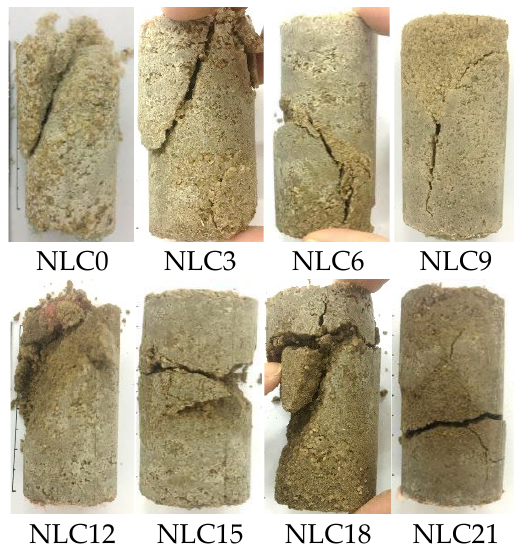
Figure 6. Destruction pattern with different clay contents (MICP-Treat). Figure 6 indicates that when the clay content is 0%, the sand particles are peeled off after the sample is damaged and become loose after damage. When the clay content is 3%, 6%, and 9%, the sample can still maintain good integrity after damage, and when the clay content is 9%, its integrity is better than that when the clay content is 3% and